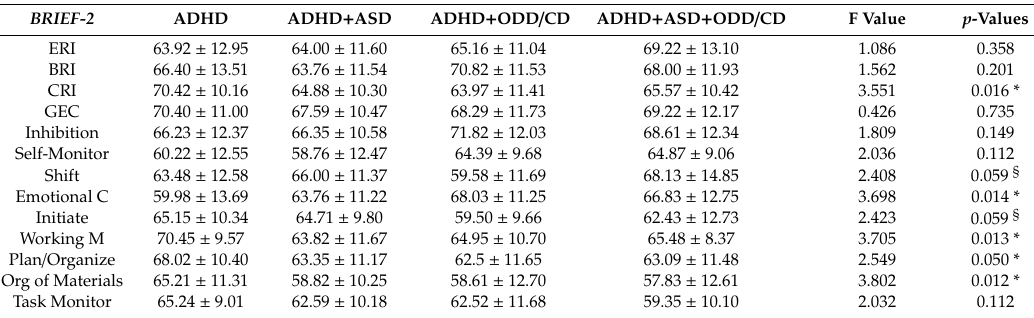
Table 3. BRIEF-2